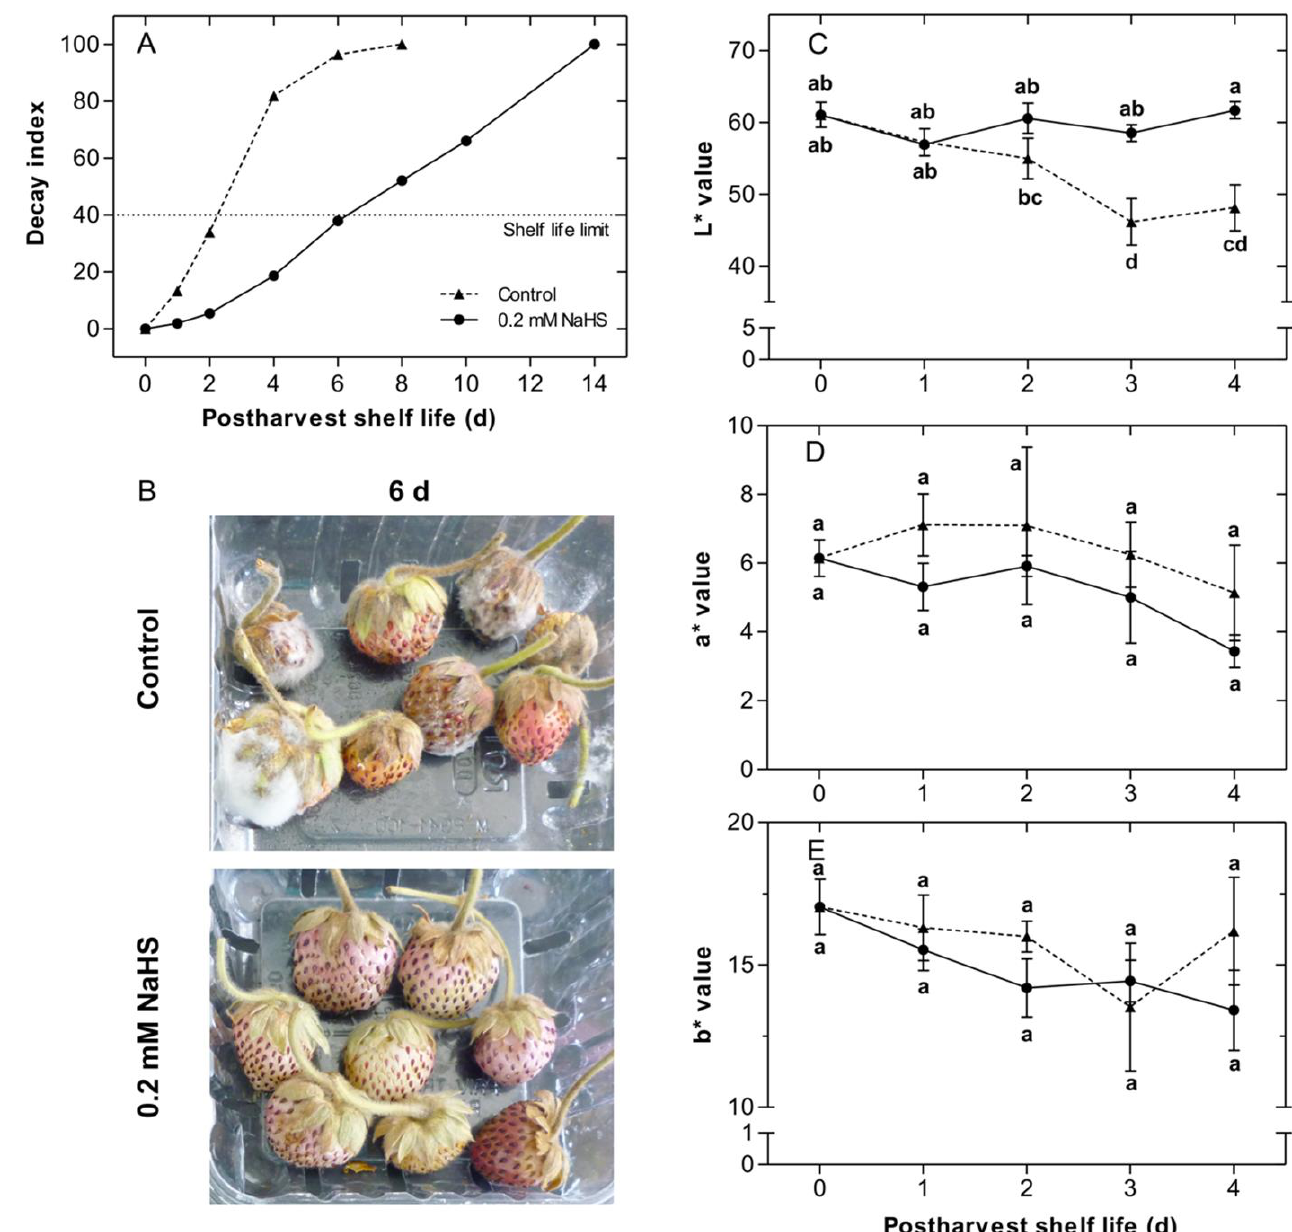
Figure 2. Effects of H 2 S treatment on decay index and color parameters during postharvest shelf-life of Chilean strawberry ( Fragaria chiloensis ) fruit. Strawberries were treated after harvest with 0.2 mM H 2 S donor NaHS. Changes in ( A ) decay index; ( B ) Images of control and H 2 S-treated strawberries after 6 d of storage at 20 °C; ( C – E ) Color parameters showing changes in L, a*, b* values, respectively. Each value is the mean of three replicates and vertical bars represent standard errors. Different letters indicate significant differences at p < 0.05. For details, see Section 4.